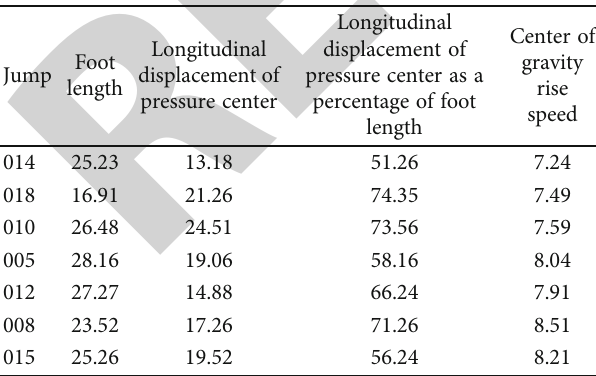
Table 5: The results of the longitudinal displacement of the plantar pressure center and the rise